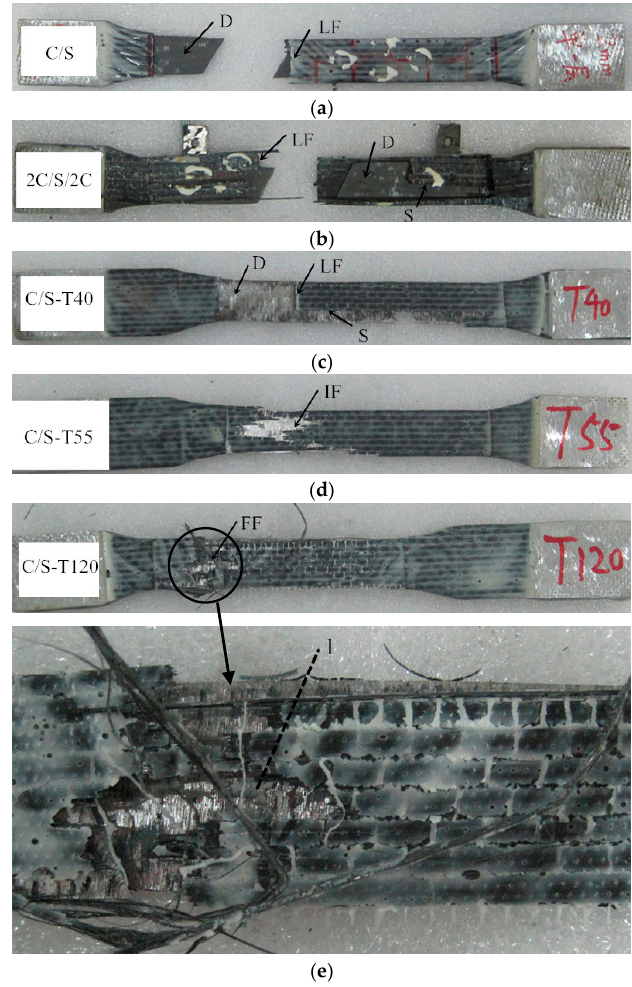
Figure 3. Failure modes of selected specimens: ( a ) C/S; ( b ) 2C/S/2C; ( c ) C/S-T40; ( d ) C/S-T55; and ( e ) C/S-T120.